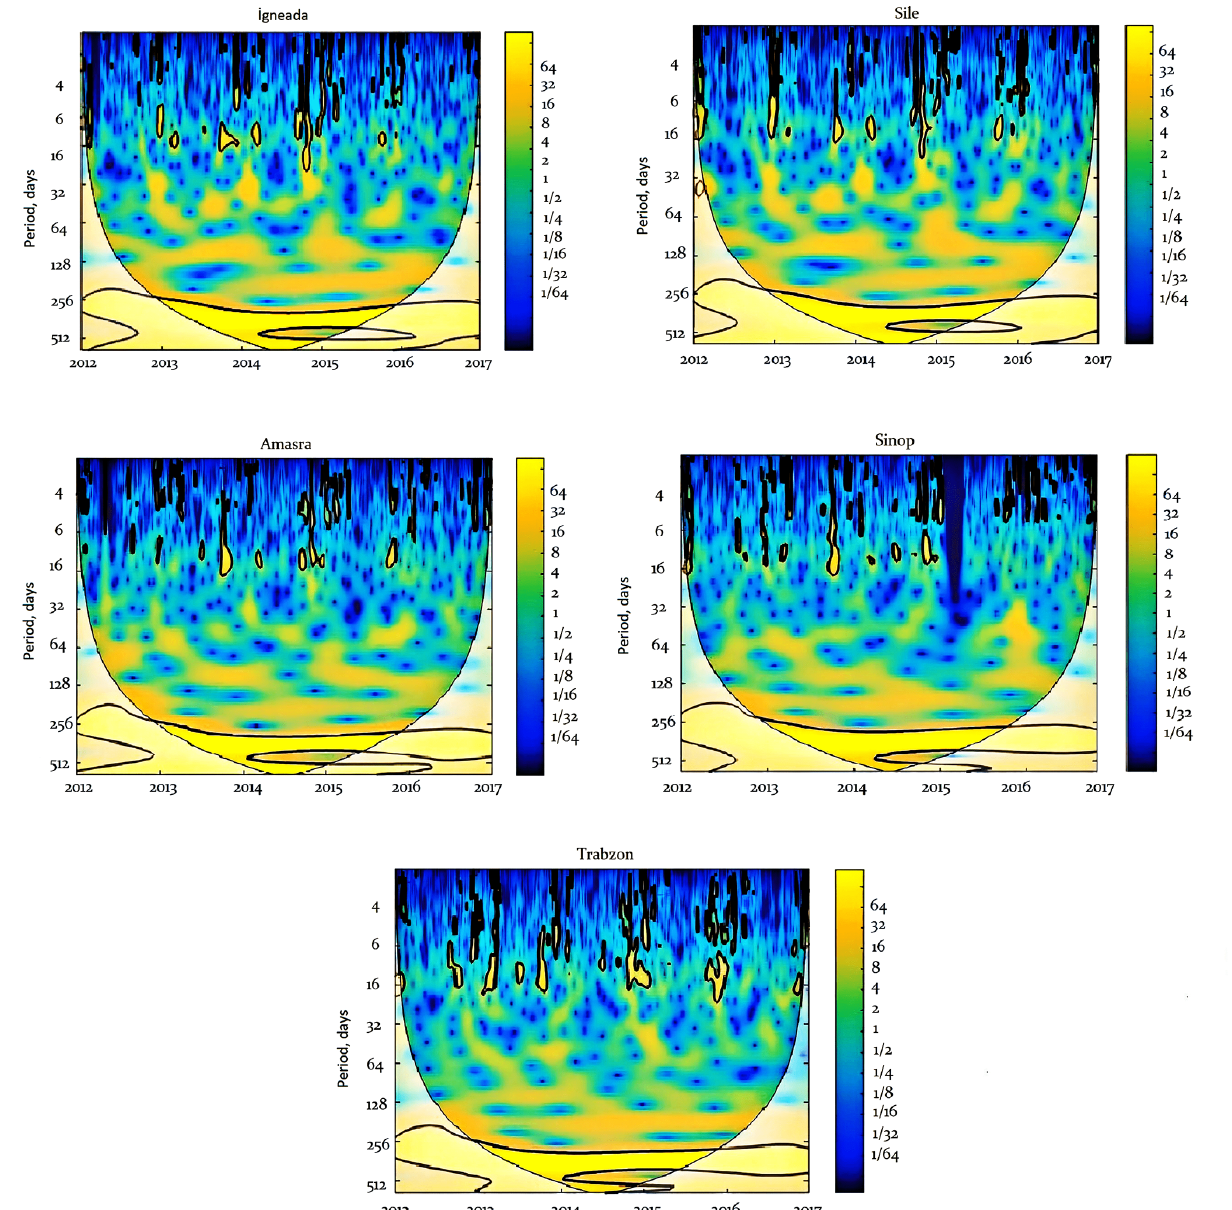
Figure 4. Wavelet power spectra of the sea levels for ˙I ˘ gneada, ¸Sile, Amasra, Sinop, and Trabzon, obtained using the Morlet wavelet. Time is indicated on the x axis (years), and the timescale (period) is shown on the y axis. The colour scale of the variance (power), shown on the z axis, ranges from blue to yellow with increasing power (variance). The areas enclosed by the black contour lines indicate the periods with a significance of above